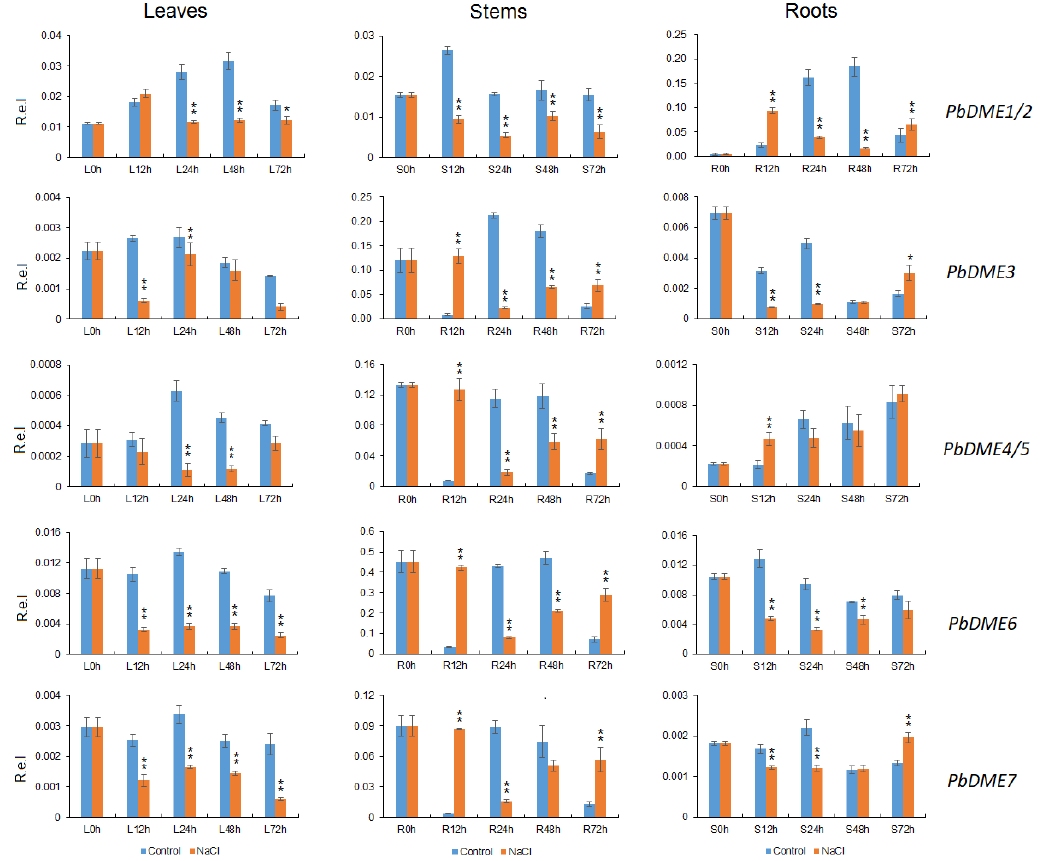
Figure 6. The patterns of expression of PbDME genes in different pear tissues in response to salt stress. Young pear plants (approximately eight leaves-old) growing in soil in pots were exposed to 200 mM NaCl by watering the plants with the salt solution. Roots (R) (a), stems (S) (b) and leaves (L) (c) were sampled at 0, 12, 24, 48 and 72 h, and relative expression was determined by RT-qPCR analysis. Relative expression was calculated using the 2 −∆ ∆ CT method. R.e.l indicates relative expression level.